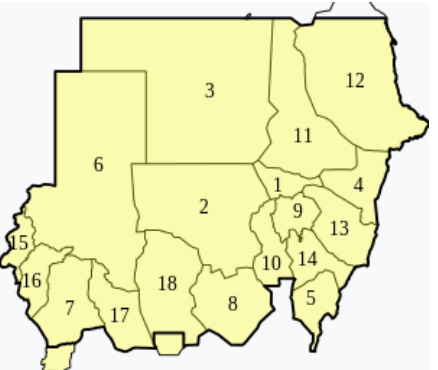
Figure 1. Map of States of Sudan (from https://en.wikipedia.org/wiki/Geography_of_Sudan (accessed on 13 December 2020)). 1 Khartoum; 2 North Kordofan; 3 Northern; 4 Kassala; 5 Blue Nile; 6 North Darfur; 7 South Darfur; 8 South Kordofan; 9 Gezira; 10 White Nile; 11 River Nile; 12 Red Sea; 13 Gedarif; 14 Sennar; 15 West Darfur; 16 Central Darfur; 17 East Darfur; 18 West Kordofan (merged with South Kordofan in 2005, and re-established in